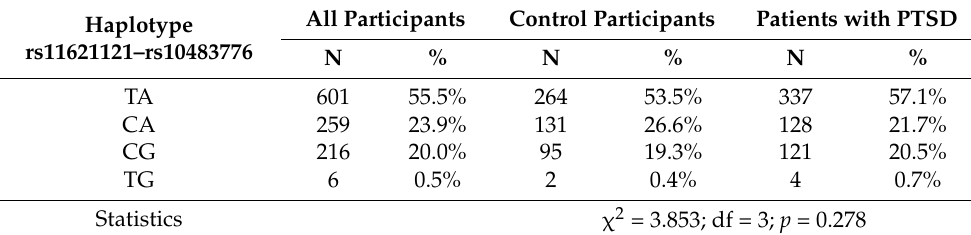
Table 3. Distribution of the rs11621121–rs10483776 haplotypes in all enrolled participants, as well as in the participants in the control and the PTSD